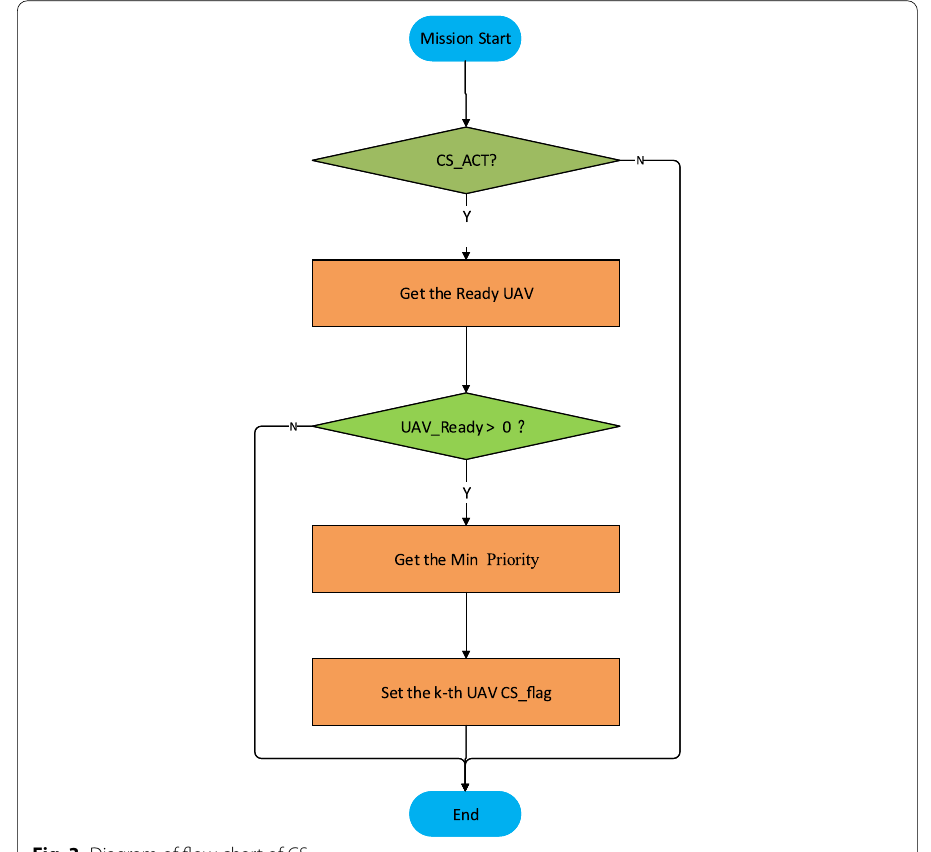
Fig. 3 Diagram of flow chart of